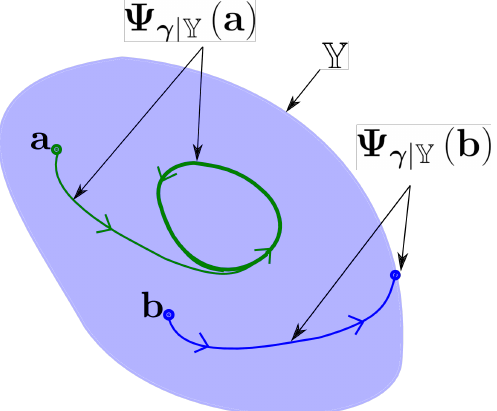
Figure 4. Illustration of the definition of a path inside a